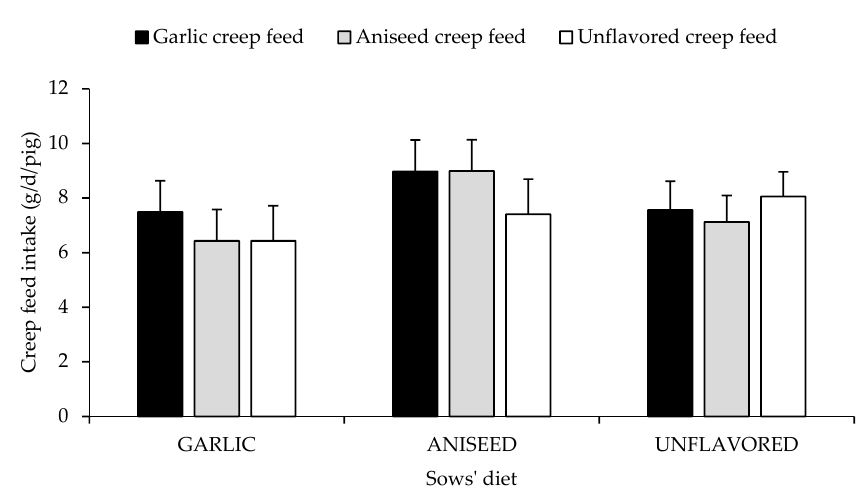
Figure 2. Daily intake of creep feed diet by piglets (days 14 to 18), who were offered (from days 10 to 20 of the suckling period) according to late-gestation maternal diet (GARLIC, ANISEED OR UNFLAVORED) and creep feed diet (Garlic, Aniseed or Unflavored). Results expressed as Least Square means ±